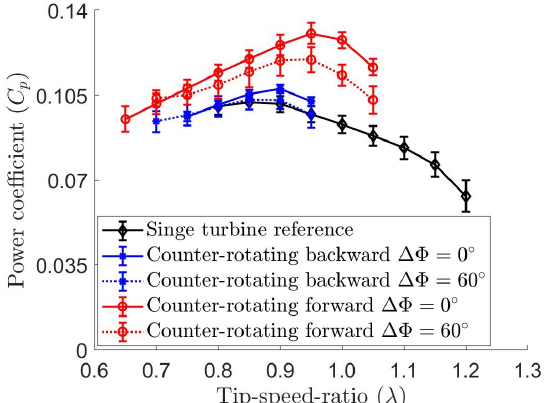
Figure 12. Power performance of the counter-rotating configurations compared to the single turbine reference C p